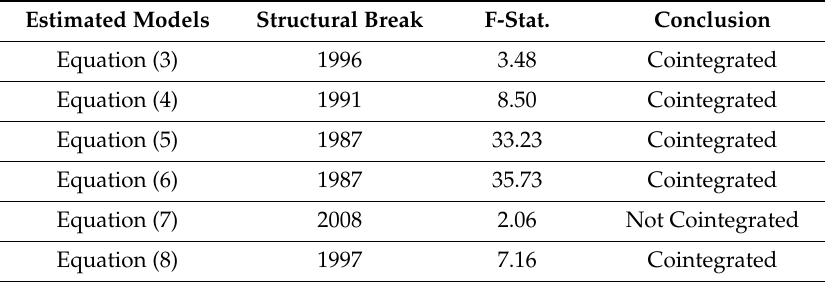
Table 2. Results of bounds cointegration